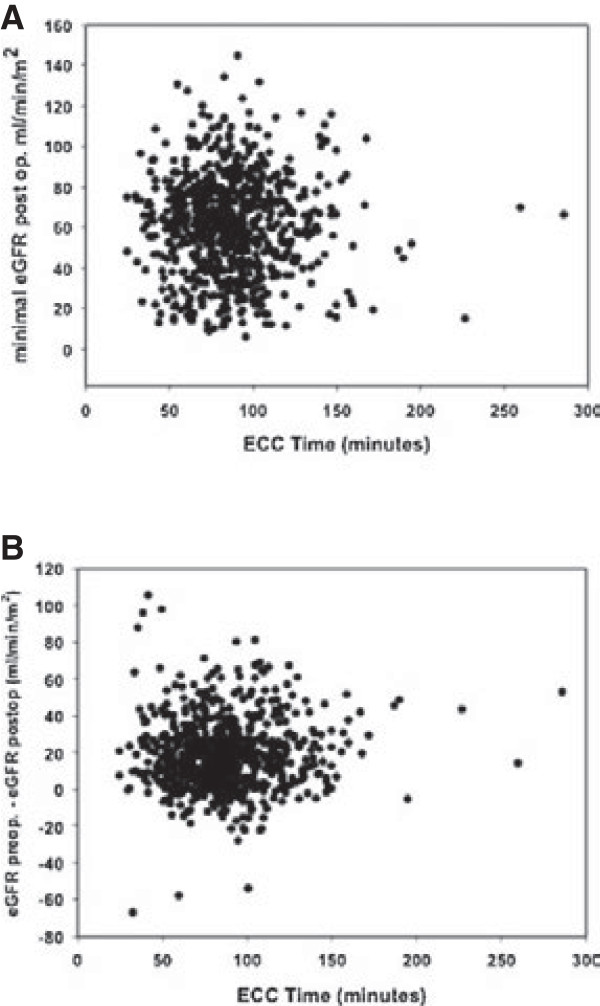
Scattered plots of extracorporeal circulation duration versus minimal postoperative eGFR (A) and versus difference in preoperative and minimal postoperative eGFR (B) showing no correlation. Pearson Product Moment Correlation > 0.050.